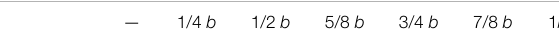
FIGURE6| Headandpercentagereductionofbubblevolume, NPSH a = 0.054